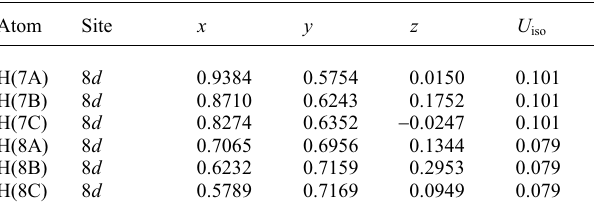
Table 2. Atomic coordinates and displacement parameters (in Å 2 )